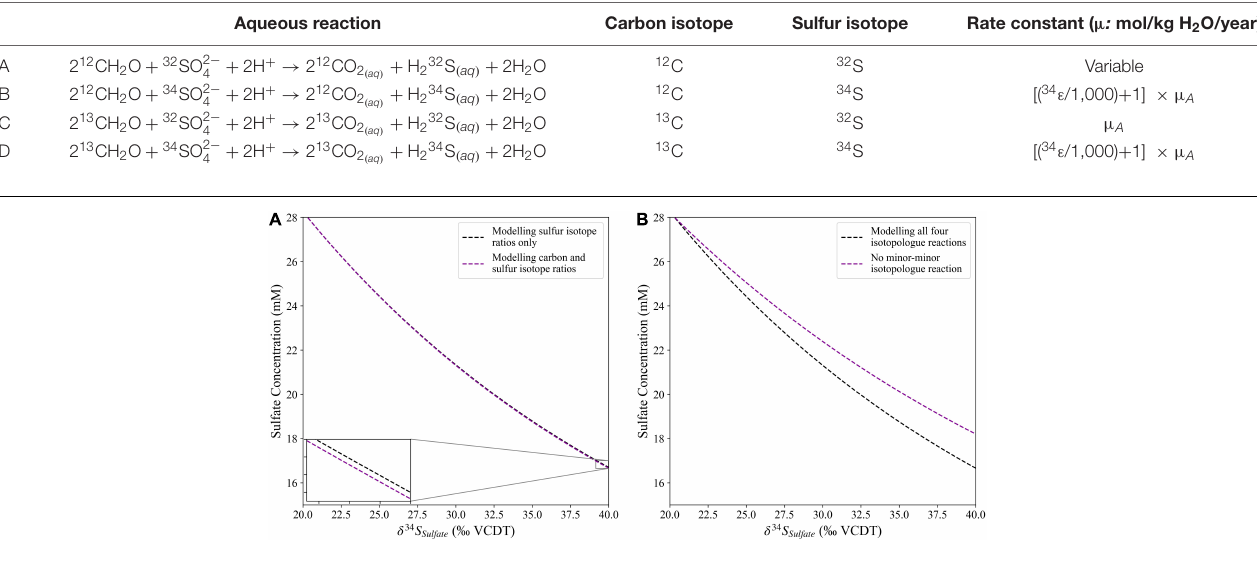
TABLE 2 | The isotopologue-specific aqueous reactions required to track the carbon and sulfur isotopic composition of DIC and sulfate (respectively) during sulfate reduction.